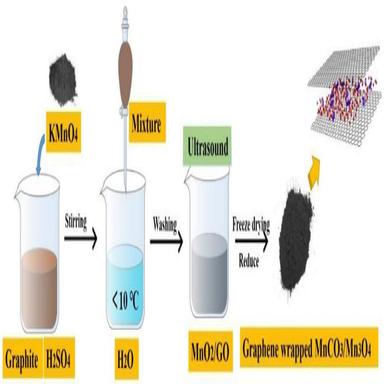
Schematic illustration of the preparation process of graphene-wrapped MnCO3/Mn3O4 nanocomposite.